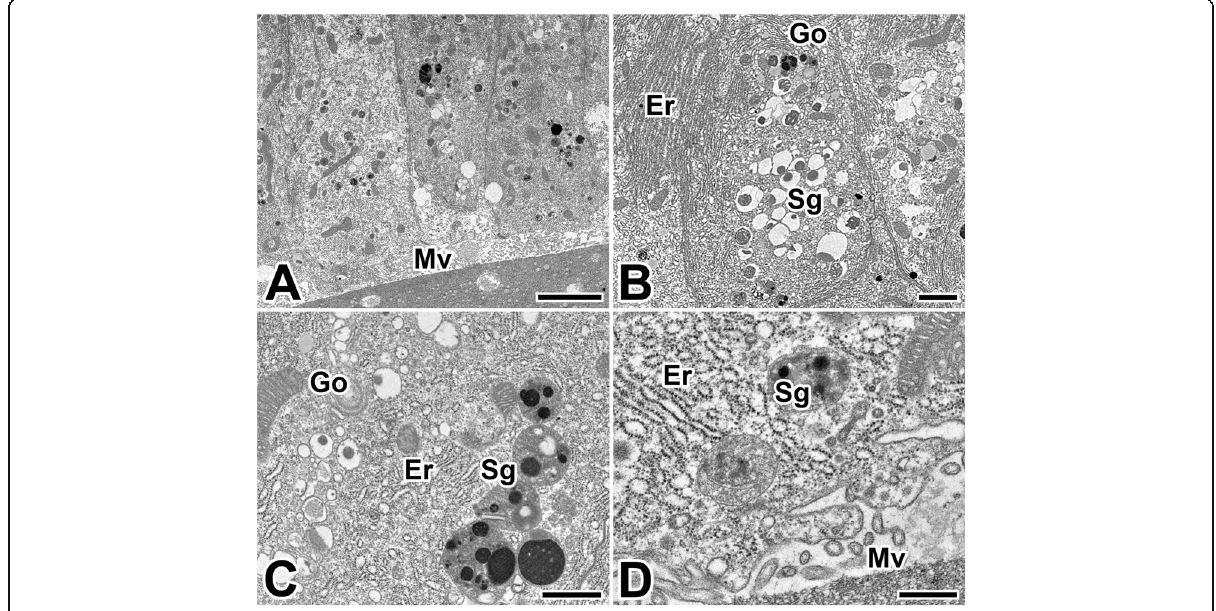
Fig. 8 Transmission electron micrographs of the anterior silk gland in the caddisworm H. nigrovittatus. a The adhesive products are produced as electron – lucent spherical granules (Sg). b , c In the cytoplasm, extensive rough endoplasmic reticulum (Er) and cisternae of Golgi apparatus are seen. Mv: microvilli. d The secretory granules are discharged into the lumen and then mixed to silk dope (Sd). Scale bars indicate 5 μ m ( a ), 2 μ m ( b ), 1 μ m ( c ), and 0.5 μ m ( d ),